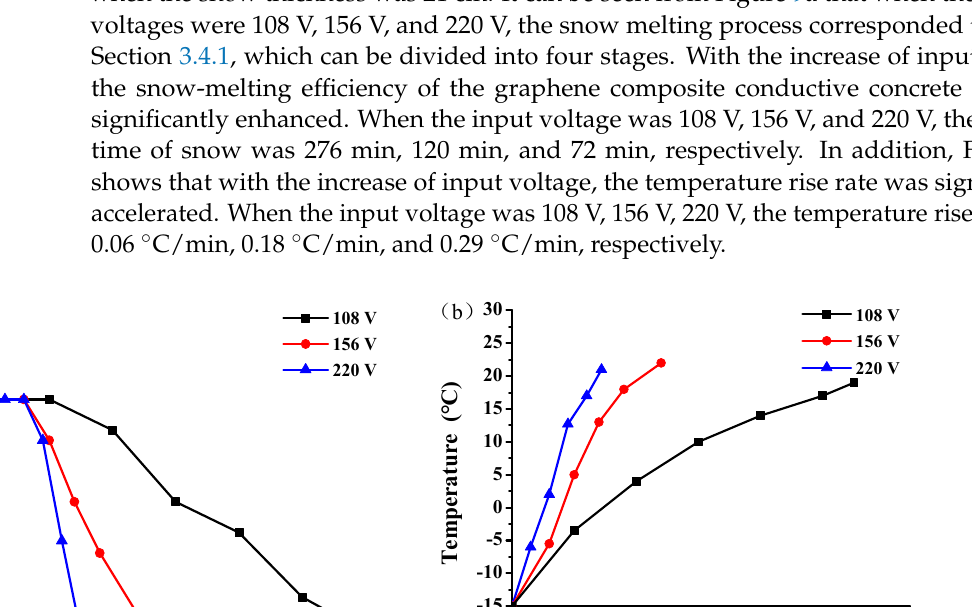
Figure 8. Input power of graphene composite conductive concrete plate with different electrode spacing.